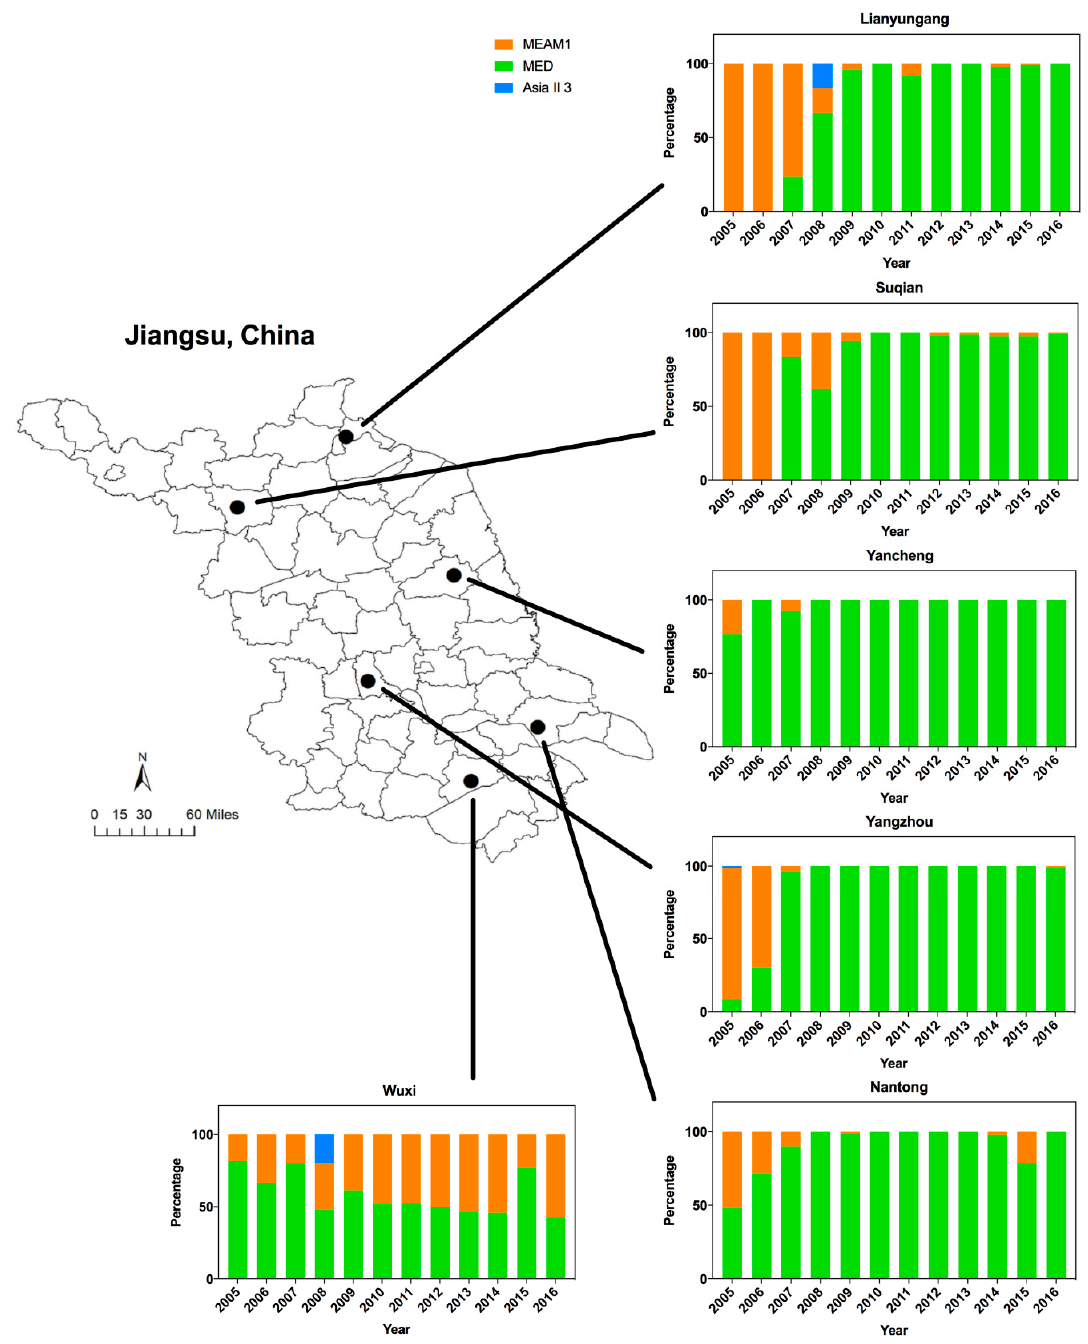
Figure 1. The dynamics of Middle East-Asia Minor 1 (MEAM1), Mediterranean (MED), and Asia II 3 in Jiangsu from 2005 to 2016. The map of Jiangsu was created using Esri’s ArcGIS platform